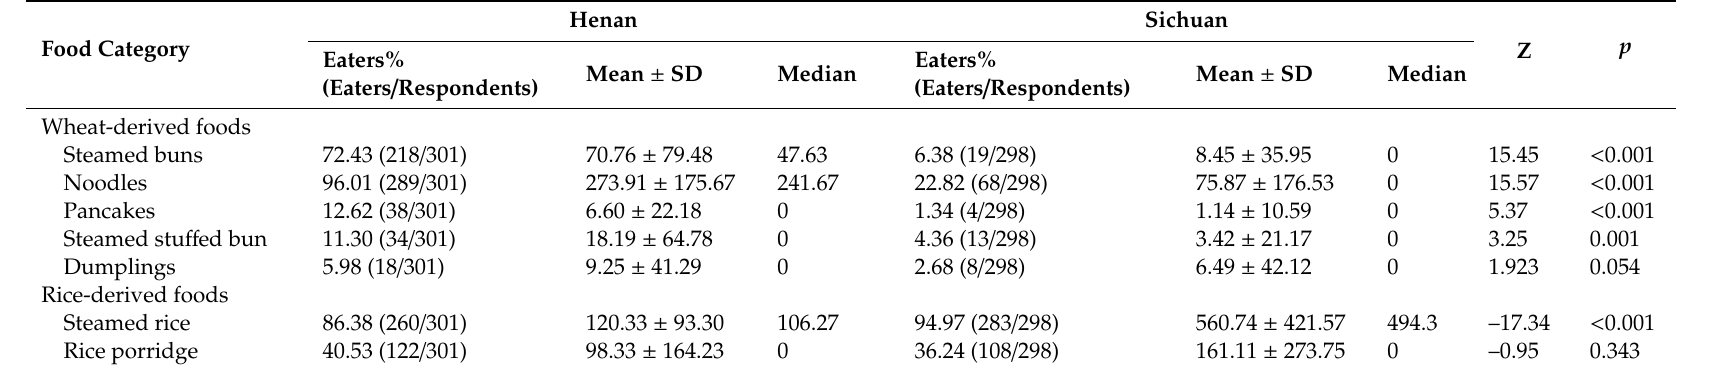
Table 3. Consumption of the cereal-based